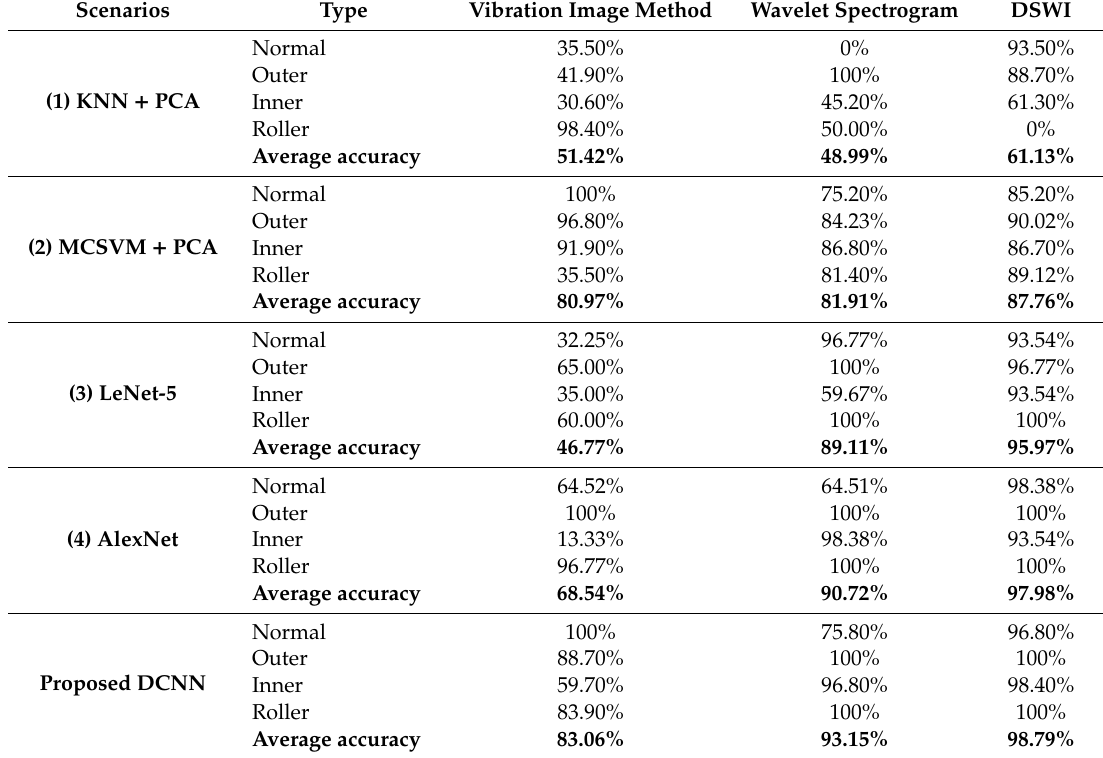
Table 2. The classification report of the test dataset for di ff erent types of input and di ff erent classification